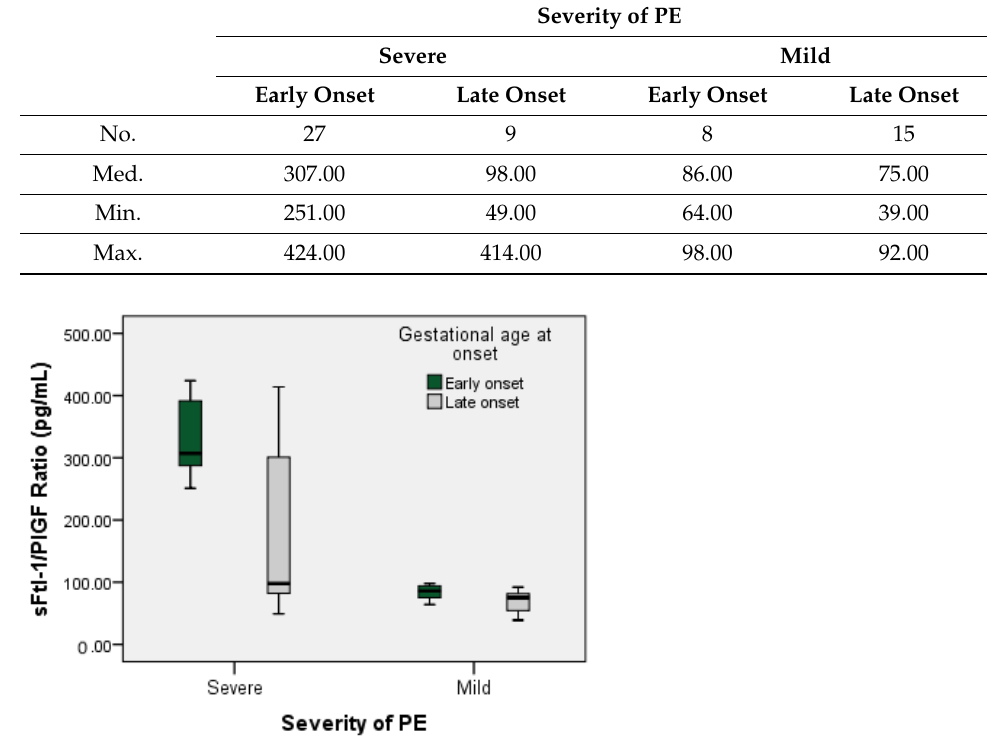
Figure 4. Box–whisker plots representing sFtl-1/PIGF ratio values depending on severity at onset of PE.